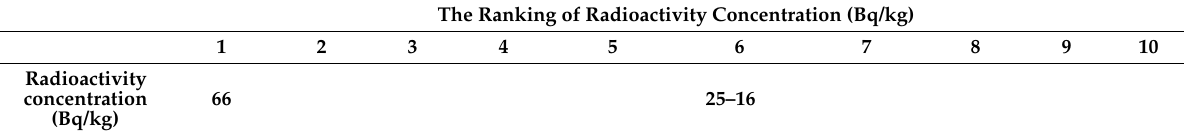
Table 4. Top 10 classification with high radioactivity in the FY2012 monitoring results. Radioactivity concentrations of these categories in the median, 95th and 99th percentile are indicated along with the food classification name. The radioactivity concentration of ND sample was set to LOD for the